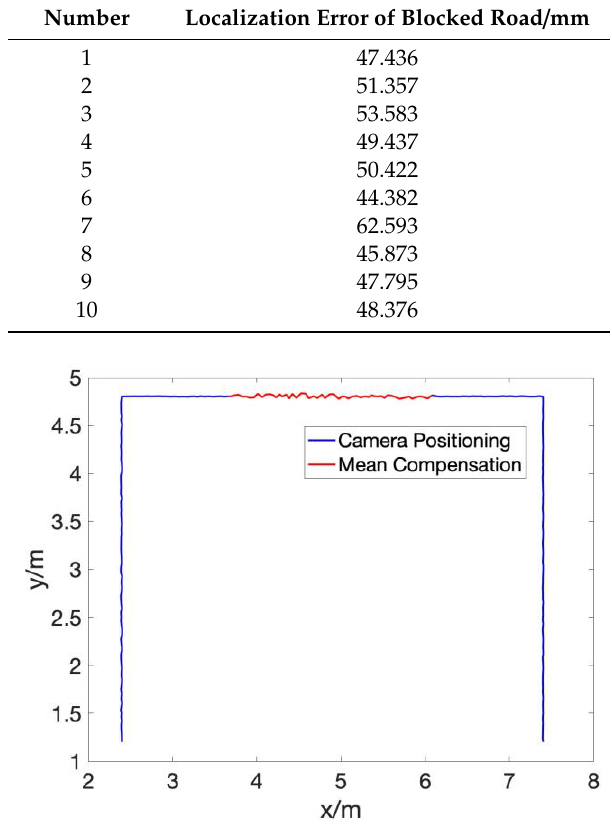
Figure 12. Location result tracking of the camera obscured road section.